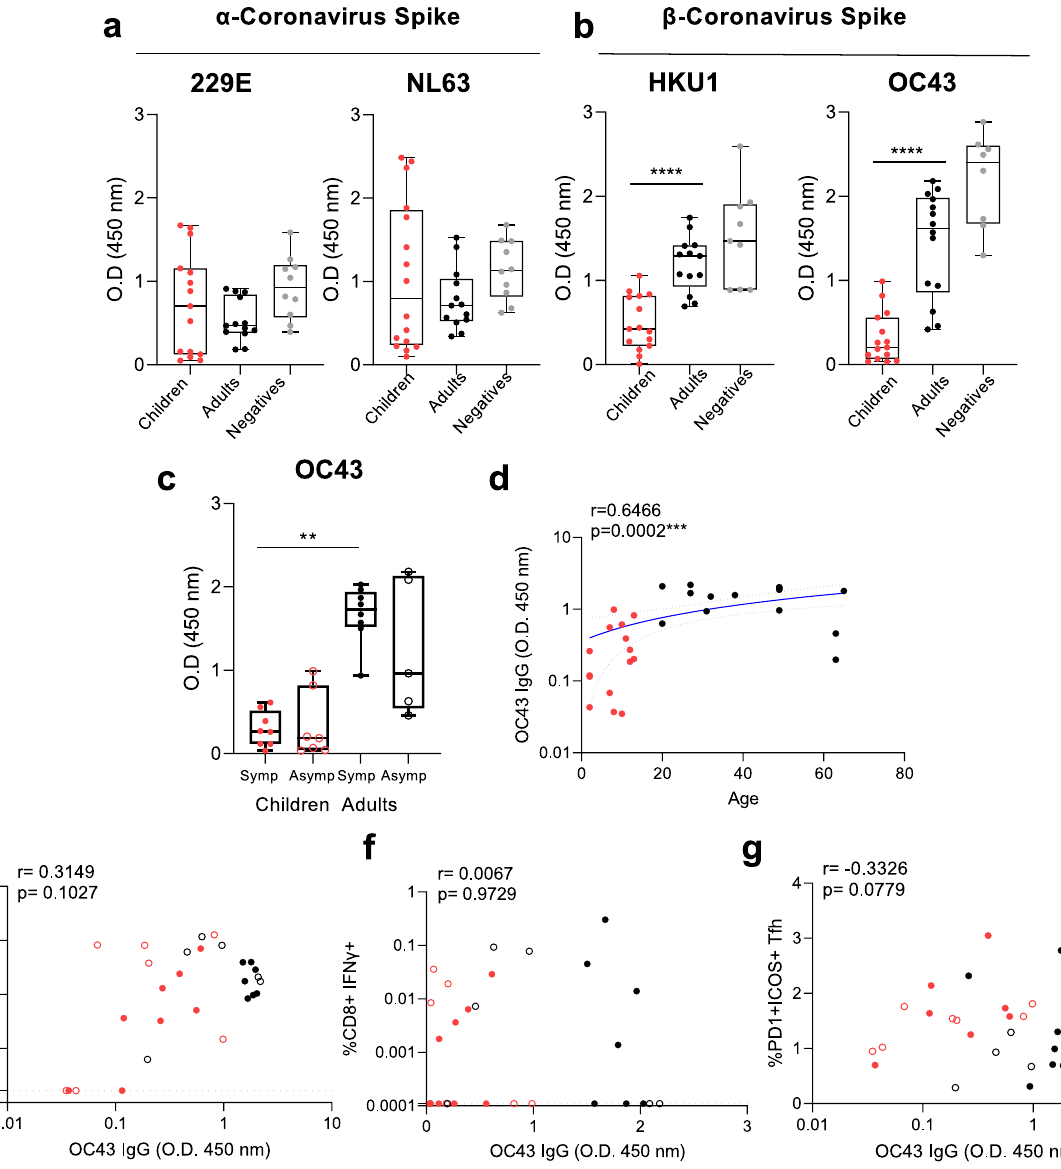
Fig. 7 Previous exposure to common cold β -coronaviruses and T cell responses. Total IgG responses to the Spike protein (S1 + S2) of common cold α (229E, NL63) ( a ) and β (HKU1, OC43) ( b ) coronaviruses measured by ELISA from acute time points (mean ± stdev: 8 ± 3.8, range: 2 – 14 days post- infection). c Strati fi cation of OC43 IgG response by symptomatic (closed circles, n = 8 children, n = 8 adults) and asymptomatic (open circles, n = 8 children, n = 5 adults). a – c Data is representative of individual donor responses with background subtracted (nonspeci fi c protein block), and displayed with box and whiskers plots of the median, upper and lower quartiles, and minimum and maximum values. Comparison between children ( n = 15) and adults ( n = 14) or adults negative controls ( n = 10) was performed using two-tailed Mann – Whitney test where ** p < 0.01, *** p < 0.001, **** p < 0.0001. c Multiple comparisons between symptomatic and asymptomatic adults and children were carried out using Kruskal – Wallis tests, where ** p < 0.01. d Correlation of OC43 IgG and age. A blue line of linear regression represents the overall trend, and blue dotted lines show the upper and lower 95% con fi dence intervals. Correlation of structural SARS-CoV-2 speci fi c IFN γ + CD4 + ( e ) or CD8 + ( f ) T cell responses and OC43 Spike IgG. Correlation of activated Tfh and OC43 ( g ) Spike IgG. R values are determined using Spearman ’ s correlation and statistically signi fi cant correlations are displayed as *** p < 0.001. Dotted lines indicate the limit of detection following subtraction of DMSO from T cell response. b **** p < 0.0001, < 0.0001, ( c ) ** p =